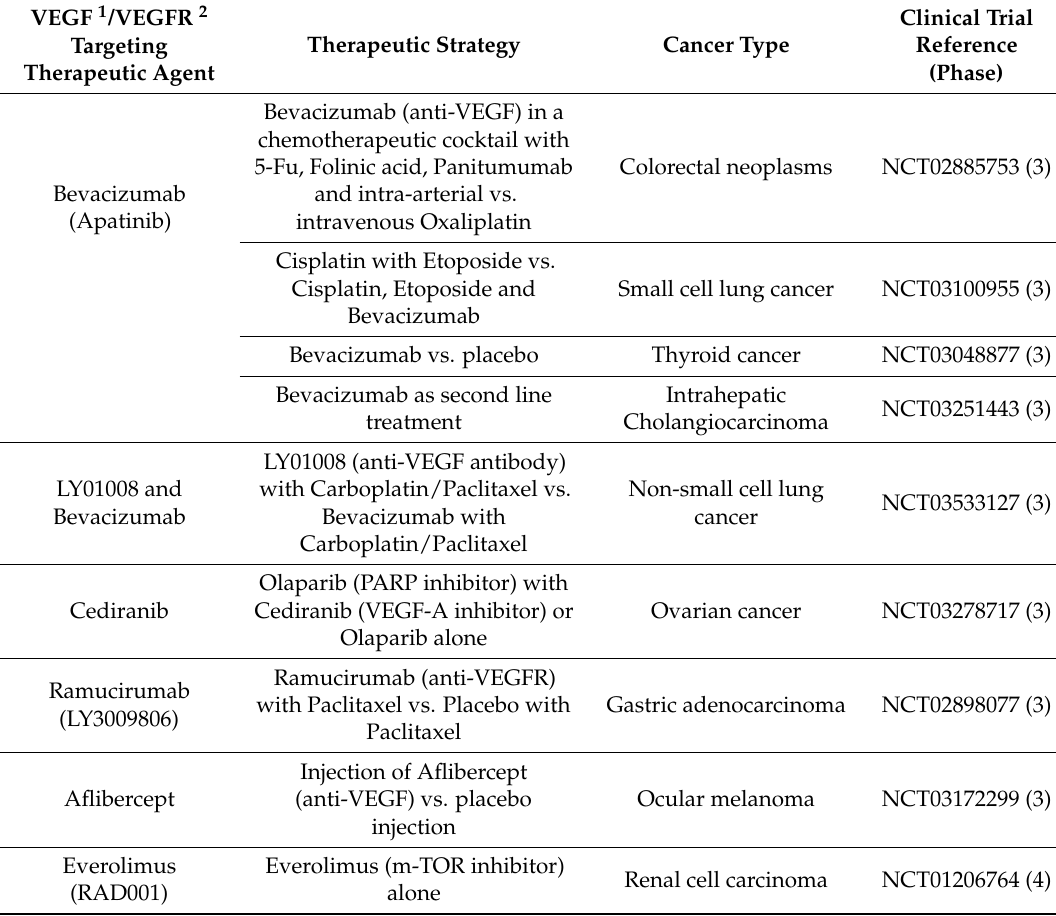
Table 1. Therapeutic agents targeting angiogenesis in interventional phase 3 and 4 clinical trials currently recruiting or not yet recruiting. Data acquired from the U.S. National library of medicine (http://clinicaltrials.gov, accessed on 18 January